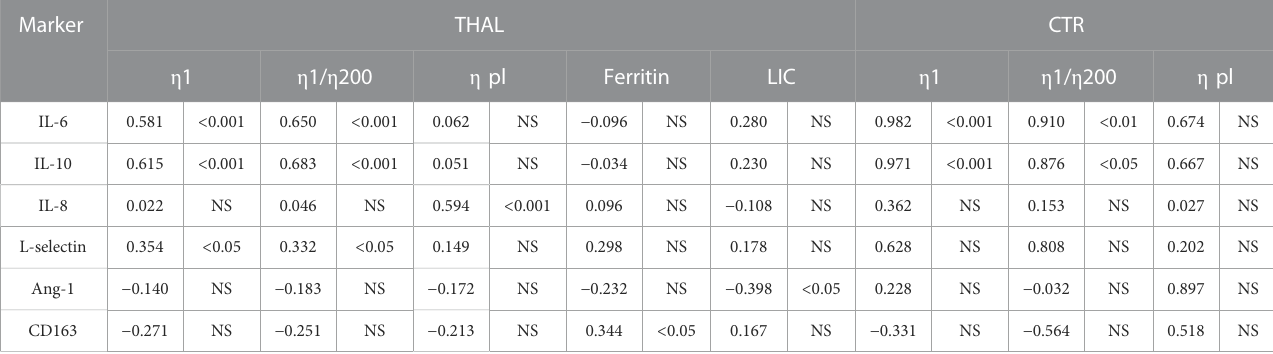
TABLE 5 Pearson ’ s correlation coef fi cients and p values between circulating markers, hemorheological parameters, ferritin levels, and LIC values in patients and healthy subjects.